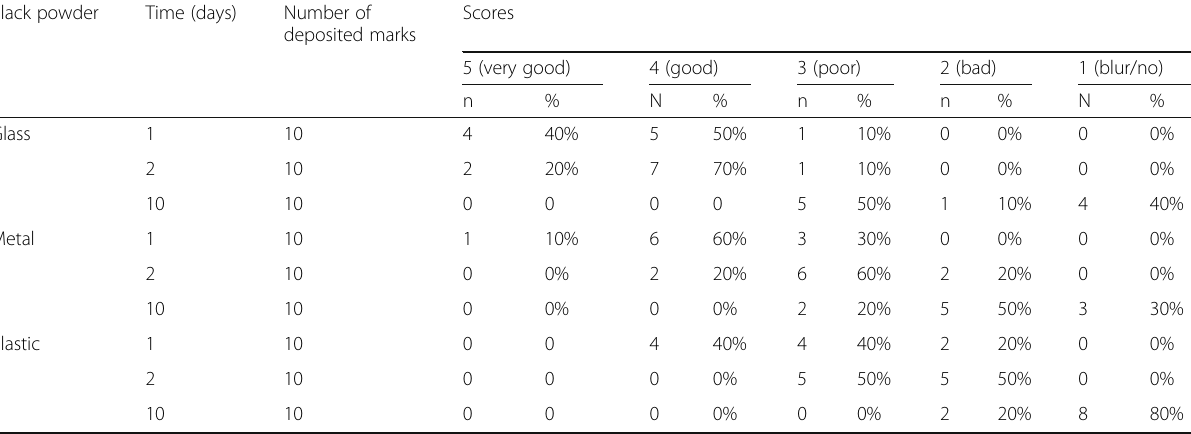
Table 4 Fingerprints development scores using black powder technique on glass, metal and plastic surfaces submerged in fresh water at 1, 2and 10 days ’ intervals according to fingerprints quality assessment